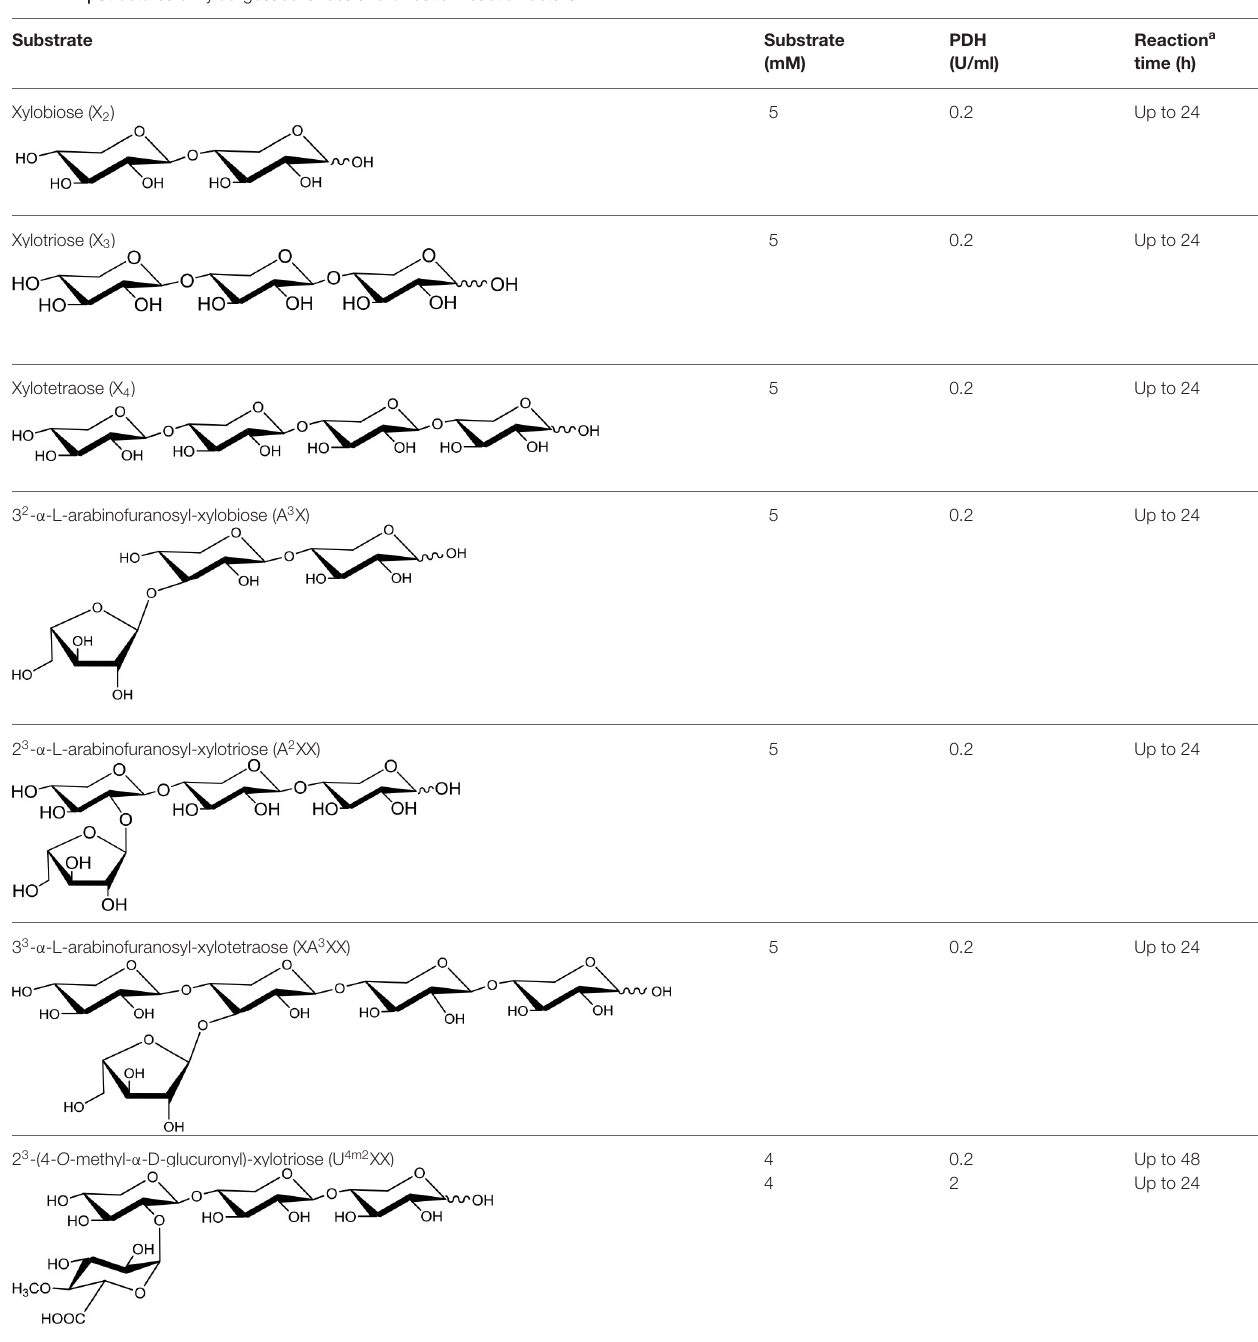
TABLE 1 | Structures of xylooligosaccharides and oxidation reaction